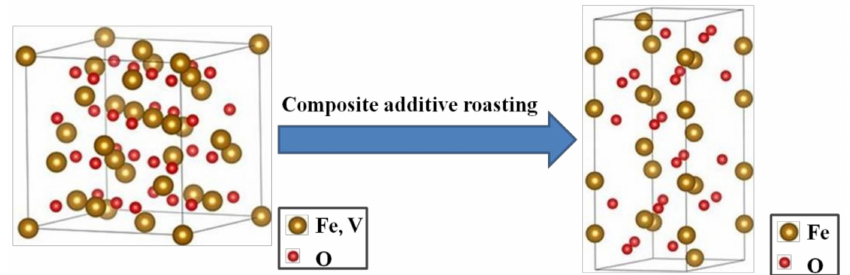
Figure 6. Crystal transformation relationship of vanadium-bearing magnetite (FeO(Fe,V) 2 O 3 ) to hematite (Fe 2 O 3